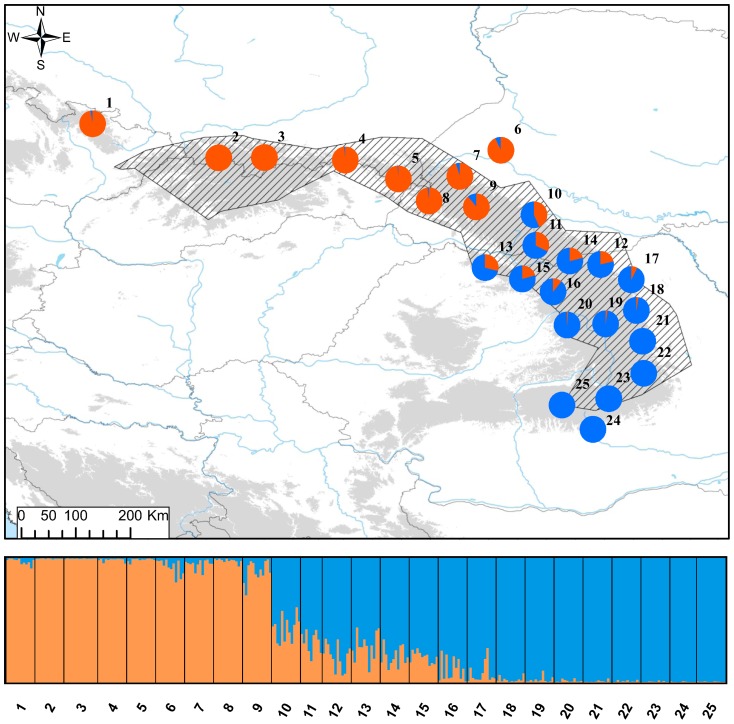
Genetic structure of L. montandoni inferred by Structure for K = 2 groups.For each population pie charts show the fraction of the genes from the northern (orange) and southern (blue) groups.